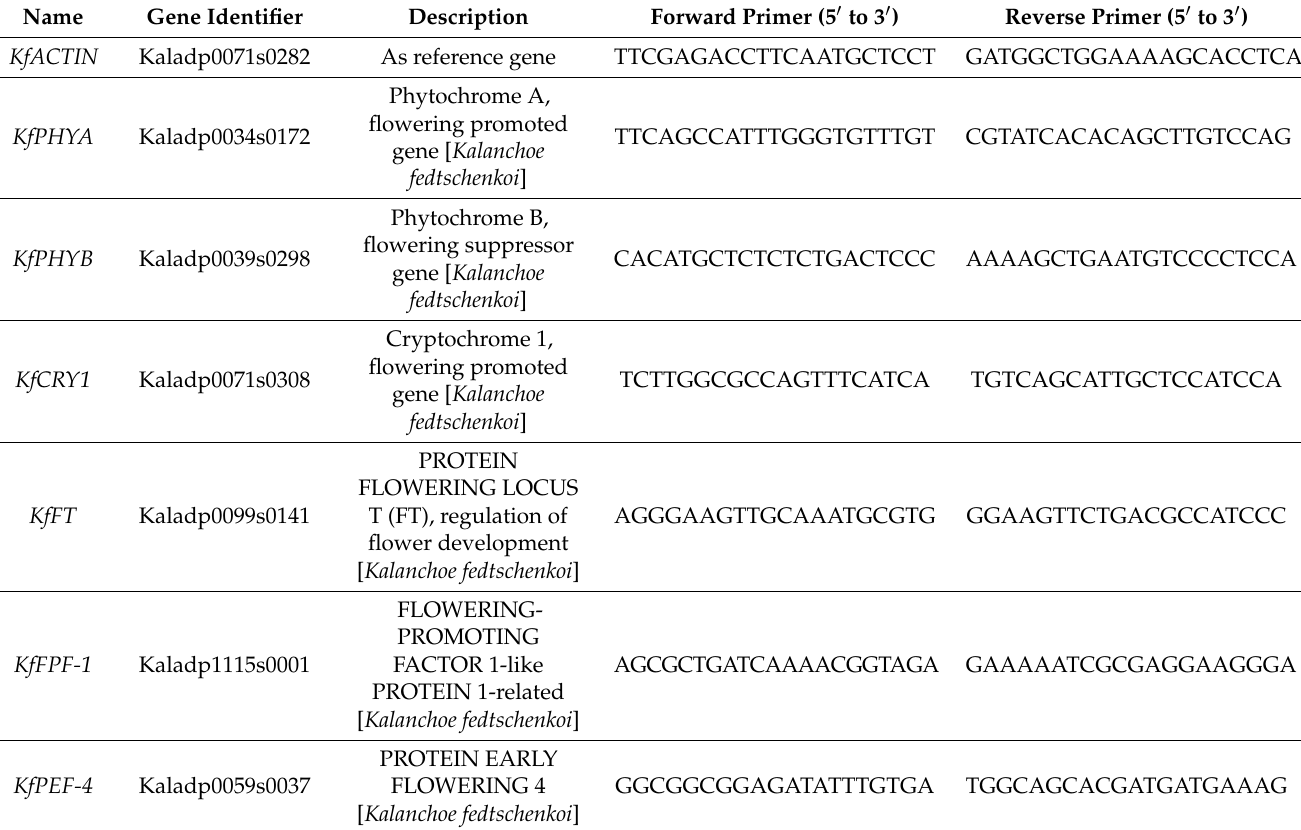
Table 1. List of the primers used to quantify the gene expression